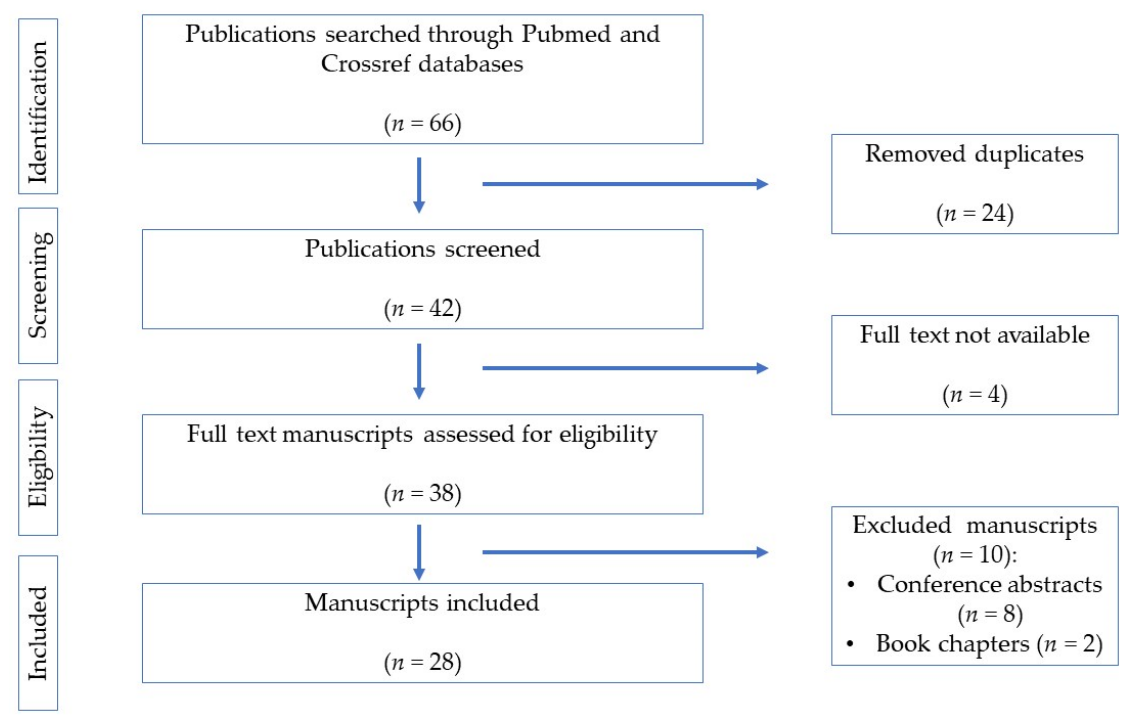
Figure 1. Flowchart of the systematic review according to PRISMA guidelines.